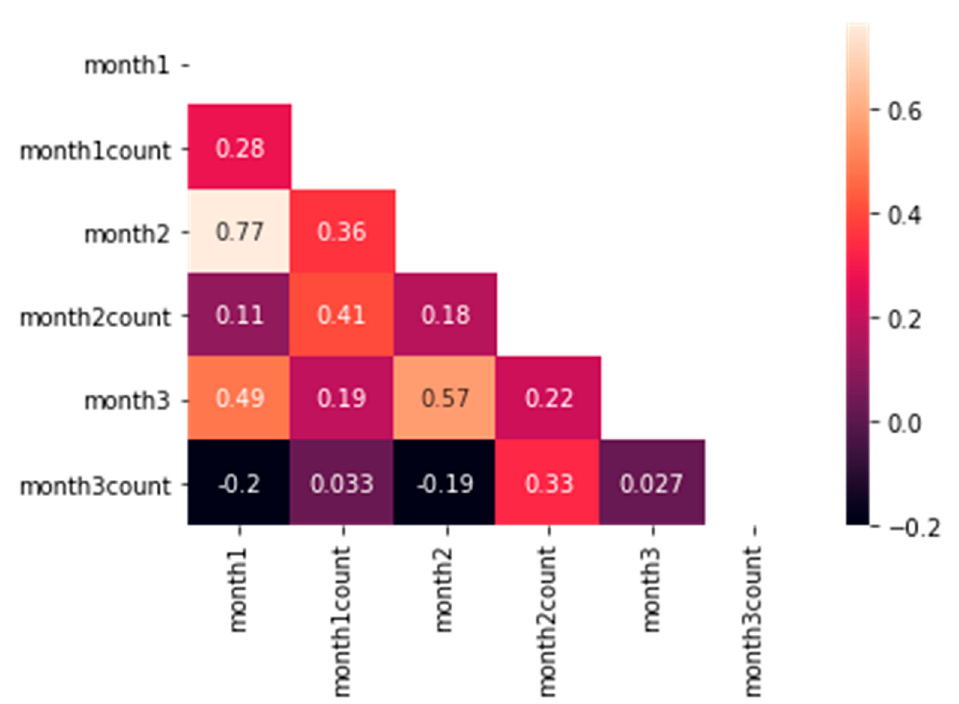
Figure 4. Correlation heatmap. Correlation of attributes of the study.